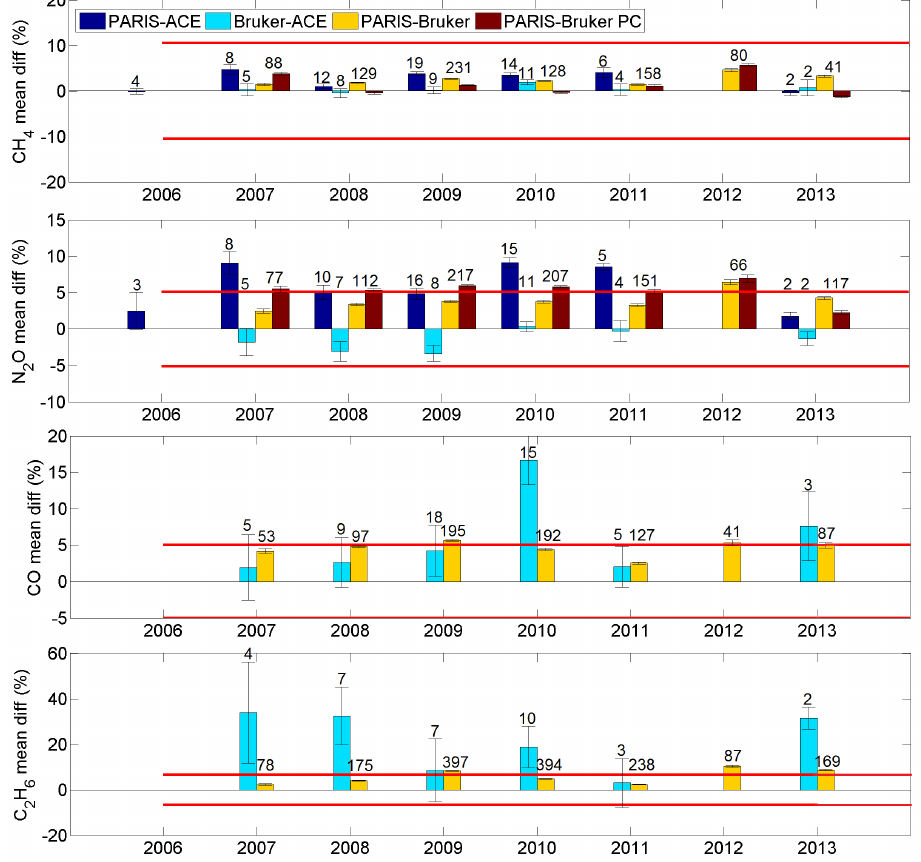
Figure 4. Same as Fig. 3 but for the tropospheric species.